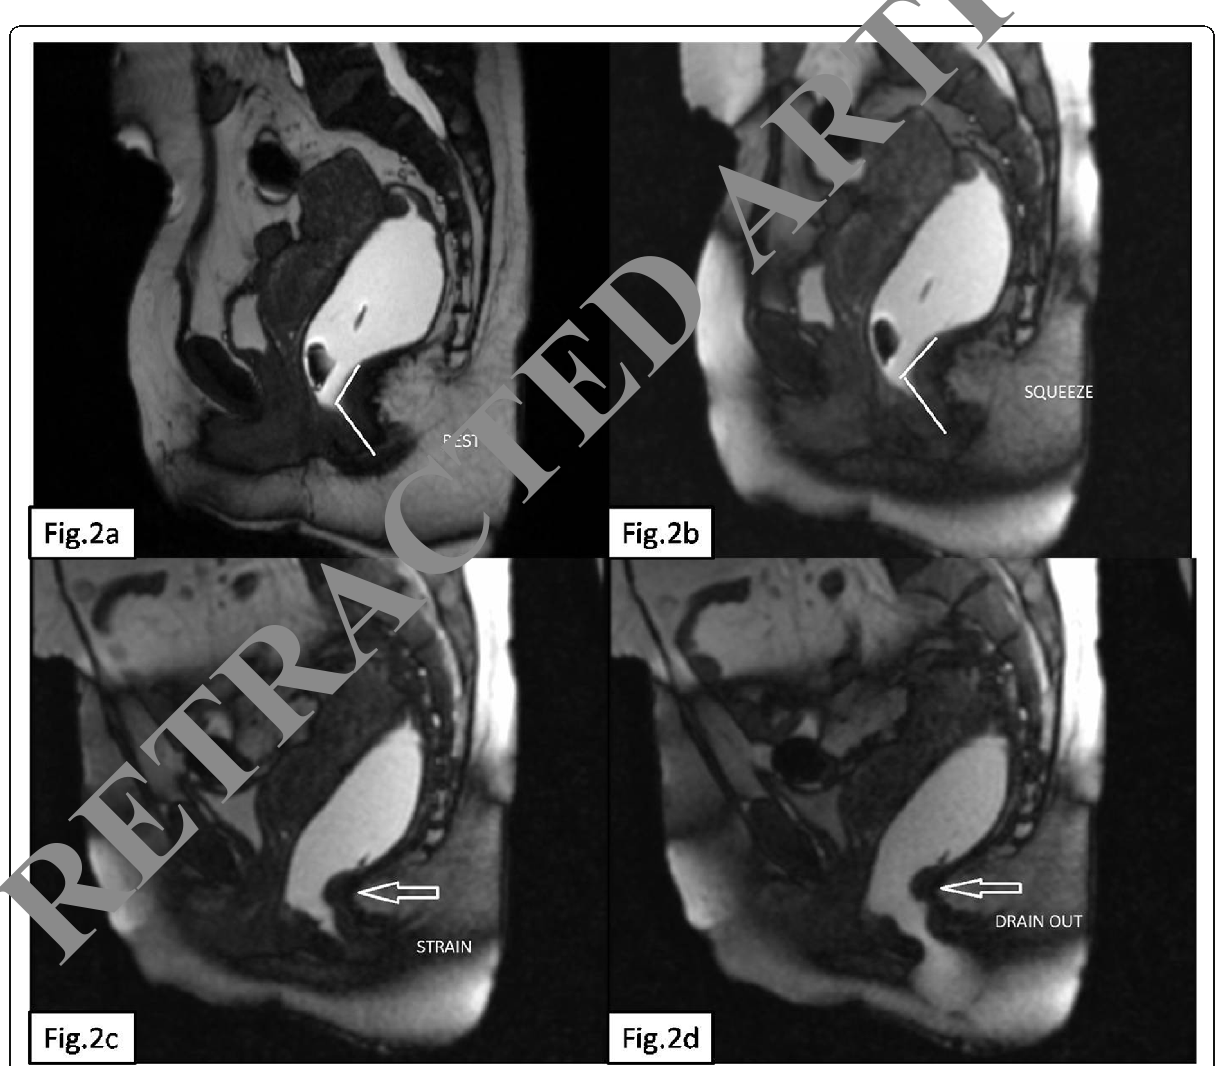
Fig. 2 Spastic perineum syndrome. Mid sagittal TRUFI images at rest ( a ) reveal an obtuse ano-rectal angle which decreases during squeeze ( b ). During the strain phase, there is further reduction in ano-rectal angle with thick pubo-coccygeal muscle (white arrow) indenting the posterior rectal wall ( c ).In defecation phase, there is further reduction in ano-rectal angle with prominent indentation of posterior rectal wall by the thickened pubo-rectalis muscle ( d